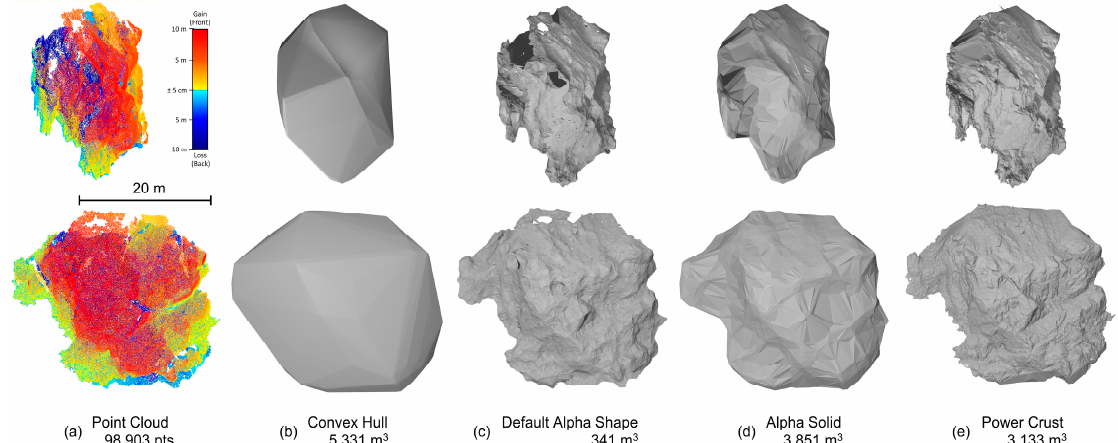
Figure 8. Surface reconstruction results for the largest rockfall point cloud, with a side view (top) and a front view (bottom), rendered in Blender [78]. ( a ) The rockfall point cloud visualized by its change detection signature. Missing surface information in the point cloud is observed where the back (cold-coloured) points are visible through the gaps in the front (warm-coloured). Missing information occurs between the boundaries of the back and front data, and across surfaces with high incidence angles relative to the scanner; ( b ) The Convex Hull reconstruction; ( c ) The Default Alpha Shape reconstruction; ( d ) The Alpha Solid reconstruction; ( e ) The Power Crust